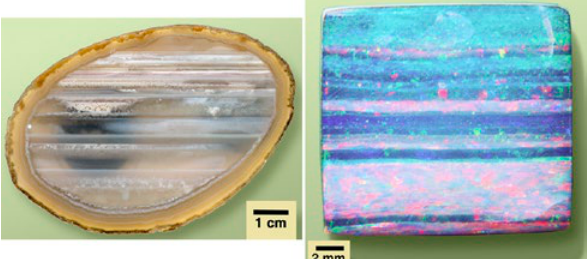
Figure 11. Silica accretions in porphyroid are usually about half to 1 cm in size but in some fluid muds they aggregate to much larger chert or agate nodules. These are called geodes. As they conden- se and loose water a peripheral region may loose water to form a much denser porous media. Similar to that in the opaline cavities, the polymeric silica particles settle into horizontal layers to form Uruguay banding as illustrated.